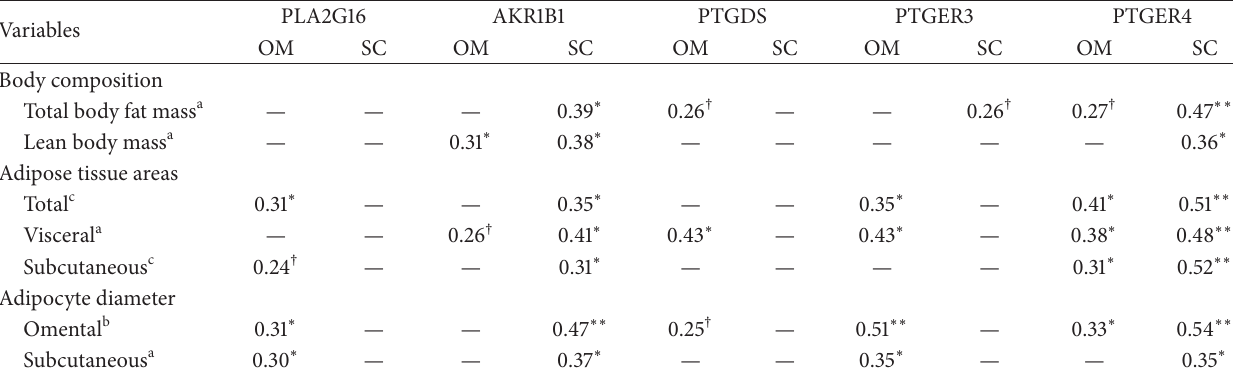
PLA2G16: phospholipase A2, AKR1B1: PGF synthase, PTGDS: PGD synthase, PTGER3: PGE receptor, and PTGER4: PGE receptor. Expression levels relative to ATP5O mRNA expression. a 𝑛 = 45, b 𝑛 = 44, c 𝑛 = 43, ∗∗ 𝑃 ≤ 0.001, ∗ 𝑃 ≤ 0.05, † 𝑃 ≤ 0.10, and (—): no significant